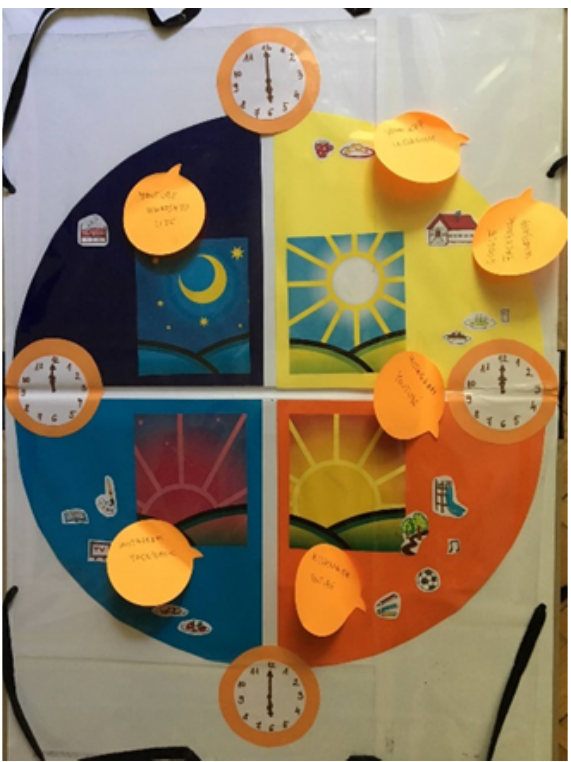
Figure 1. The “app